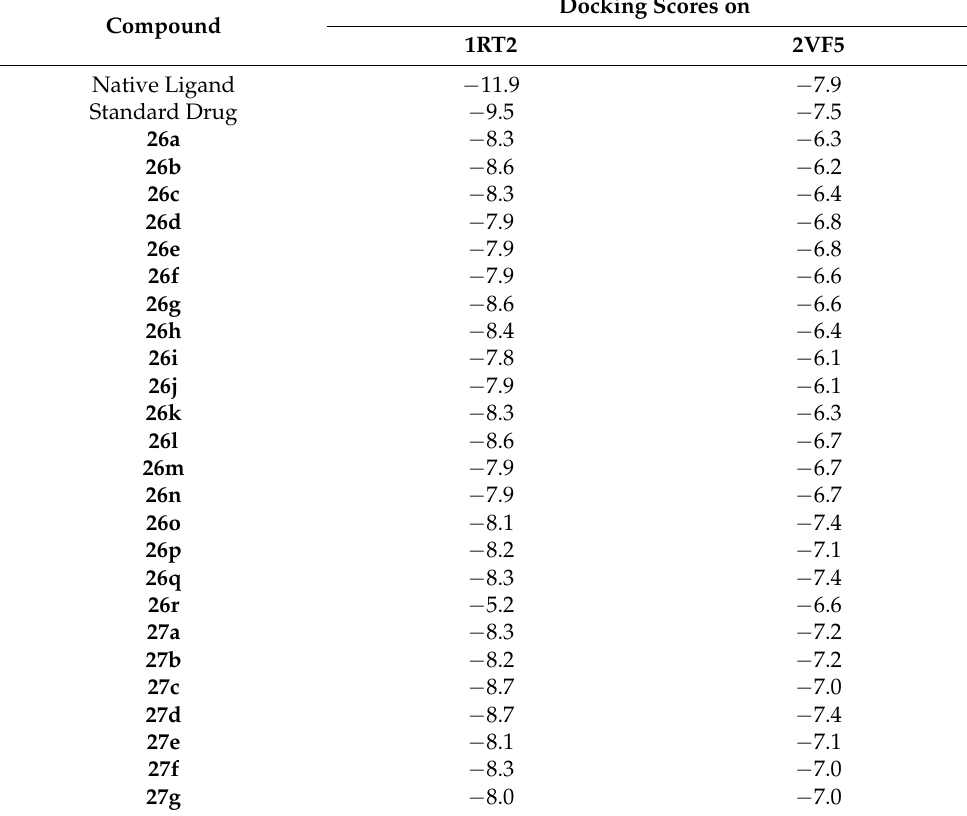
Table 3. Docking scores of the designed compounds in active site of HIV-1-reverse transcriptase